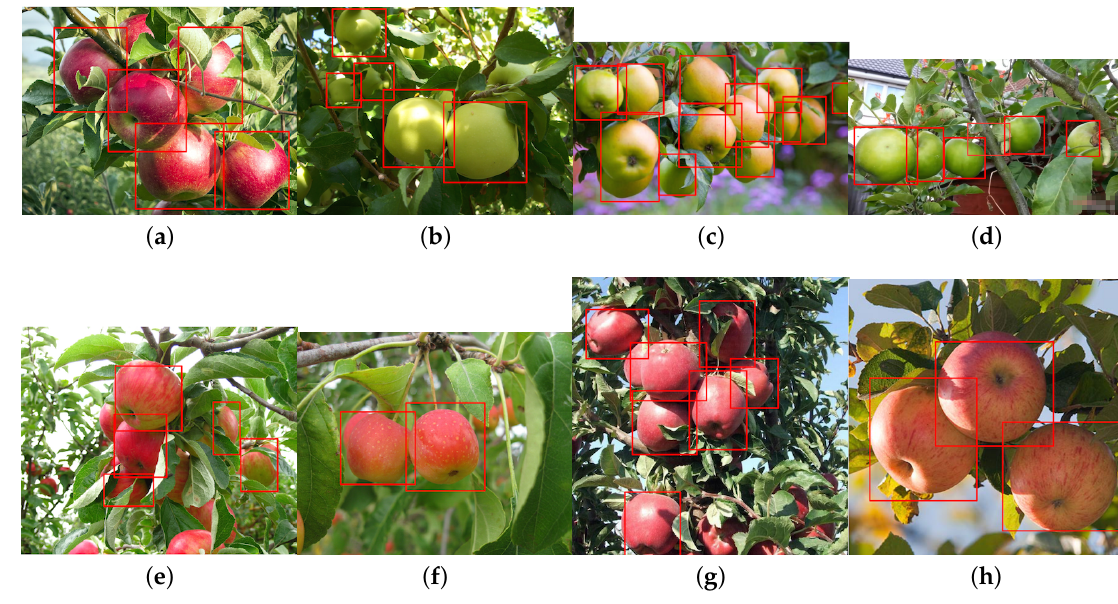
Figure 17. Eight instances of red ( a , e – h ) and green ( b – d ) apples detection (different varieties). Images are obtained from Google Images. Above each detection is the classification confidence output from the